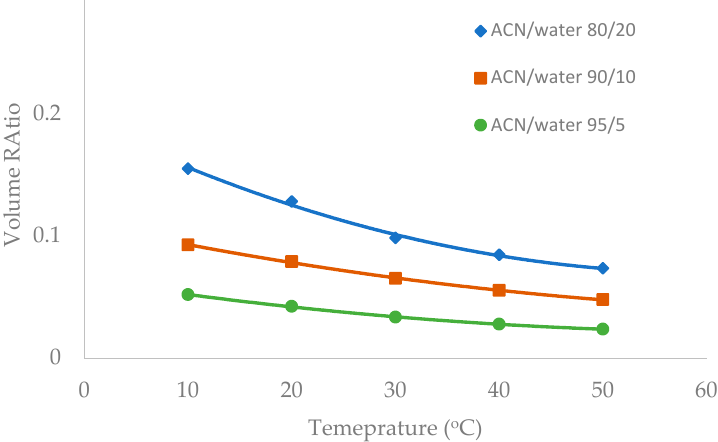
Figure 8. The effect of column temperature on the volume ratio ( β ) values for LUNA HILIC column (3.0 µm, 187 Å, 4.6 × 150 mm). The mobile phase contains 5 mM ammonium acetate.